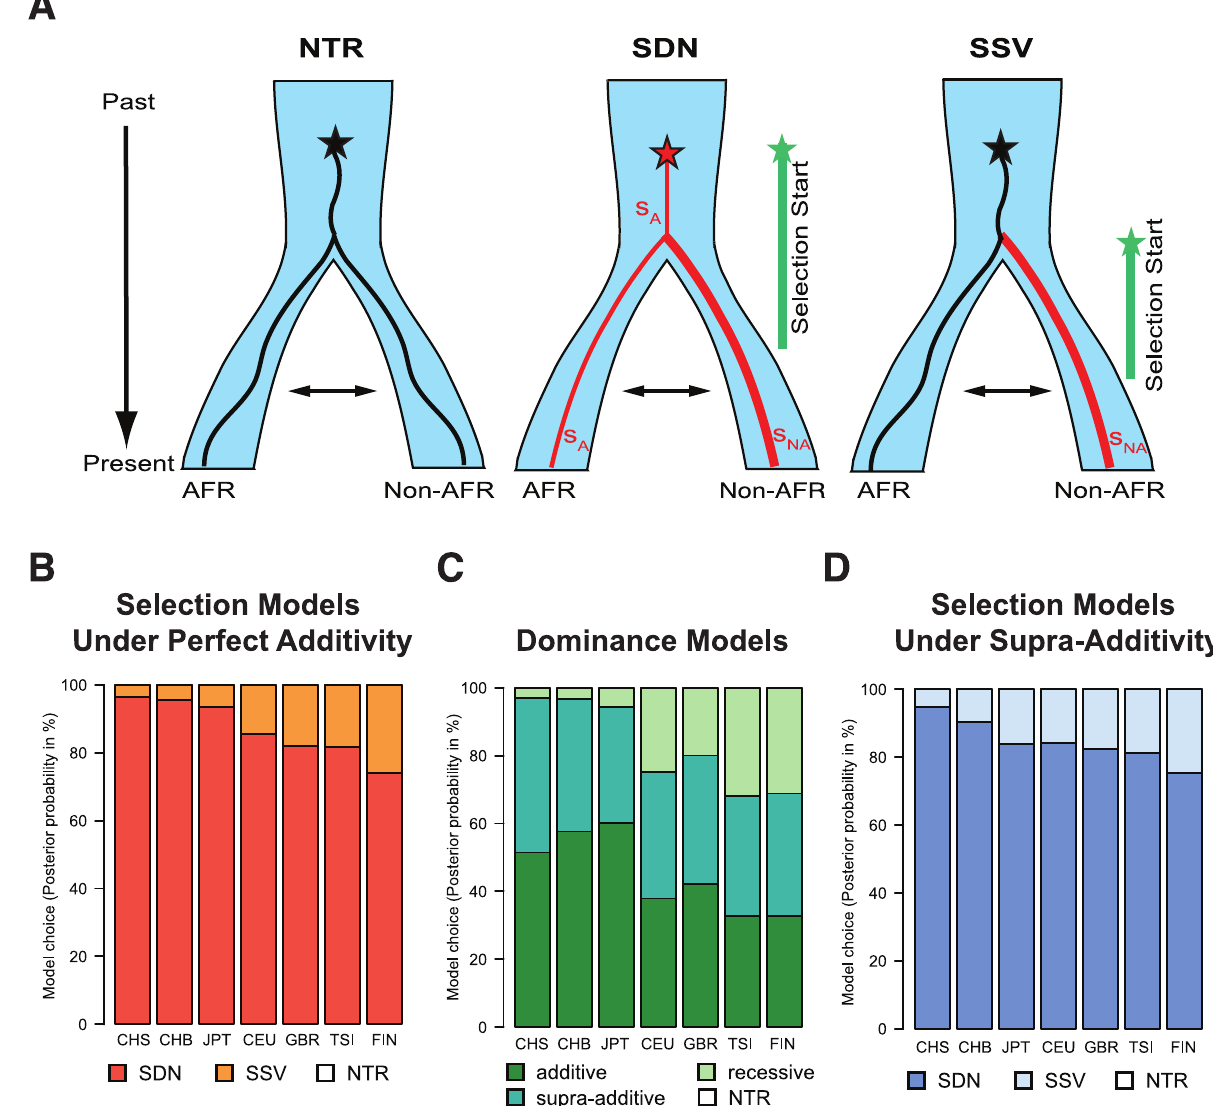
Figure 5. (A) Graphical representation of the different models of selection tested in the ABC analysis (NTR - neutral, SDN - selection on a de novo mutation, and SSV - selection on standing variation). We simulated one ancestral population that splits at the out-of-Africa event (at 51,000 years ago) into the African (AFR) and the non-African (non-AFR) populations, which experience subsequent migration. The star indicates the appearance of the focal mutation. In the first case the neutral (black) mutation appeared and evolved under neutrality in both populations. In the SDN model the advantageous mutation (red) is immediately under positive selection with strength s A , and time when selection started t mut (the prior parameter space for t mut is indicated by a green line); selection strength is allowed to change in the non-African population to s NA . In the SSV model the neutral (black) mutation appeared and evolved under neutrality, becoming advantageous in the non-African population (red line) at time t mut . Prior parameter spaces can be found in methods. ( B ) Posterior probabilities of the model choice for the different selection models under perfect additivity. ( C ) Posterior probabilities of the model choice for the different dominance models (and neutrality, NTR). For all models except NTR the posterior probability represent the sum for the SDN and SSV selection models. ( D ) Posterior probabilities of the model choice for the different selection models under the supra-additive model. In ( B ), ( C ), and ( D ), NTR has negligible posterior probability and is therefore not